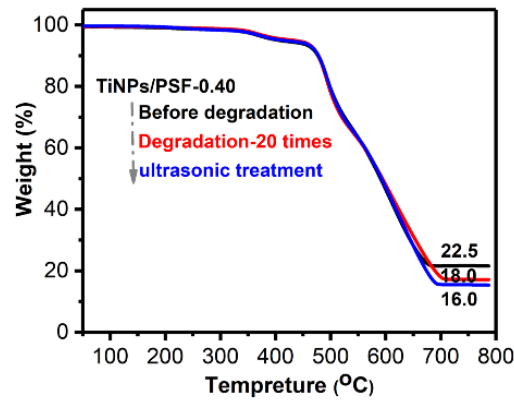
Figure 8. TG analysis of microspheres from top to bottom is TiNPs/PSF-0.40 before degradation, degradation 20 times, after ultrasound treatment.